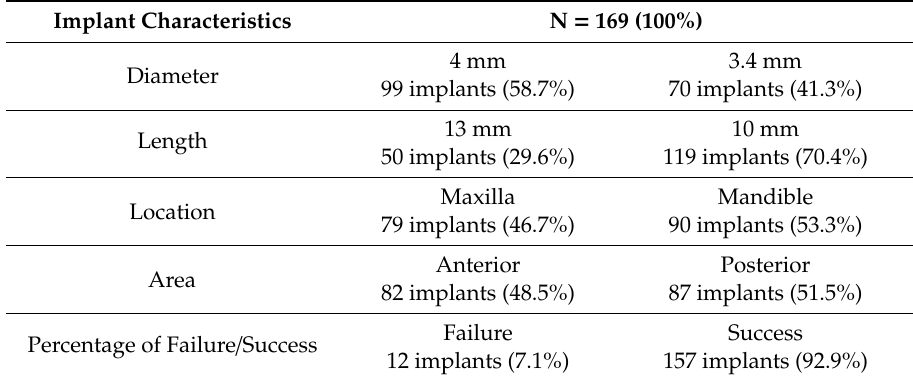
Table 2. Description of the total sample implant characteristics: diameter, length, location, area, and percentage of failure and success